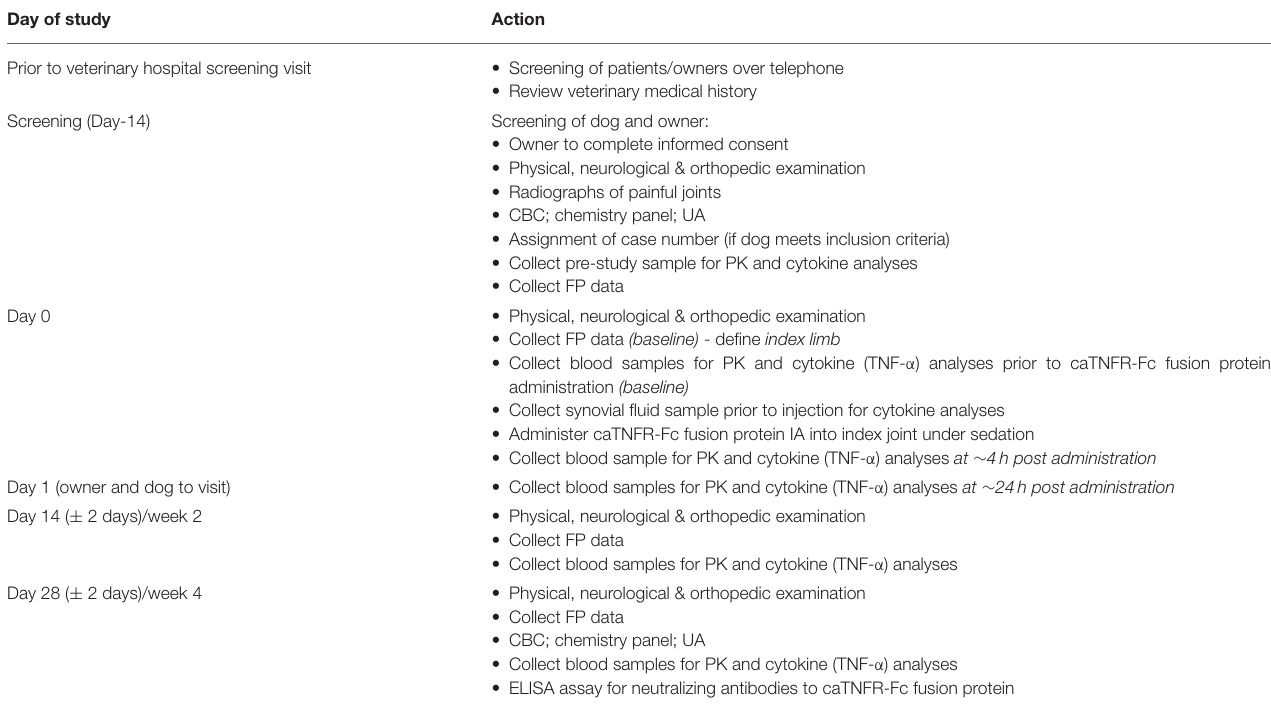
TABLE 1 | Study outline. Day of